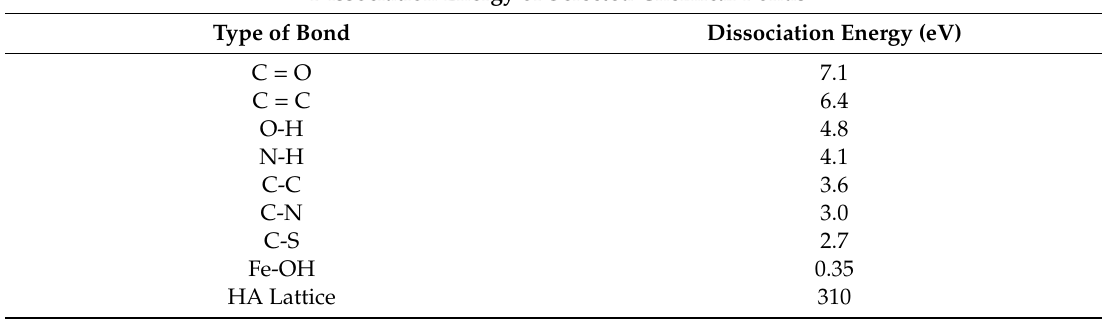
Table 2. Dissociation energy, expressed in eV values, required to break the bonds (covalent, coordinate, etc.) that bind atoms within molecules. Examples represent component molecules within tissue water and biofluids, and also ionic forces within the crystal lattice of hydroxyapatite. Data reproduced with thanks from M ó , O; Y á ñez, M, et al. J Phys Chem A. 2005 , 109(19), 4359–4365